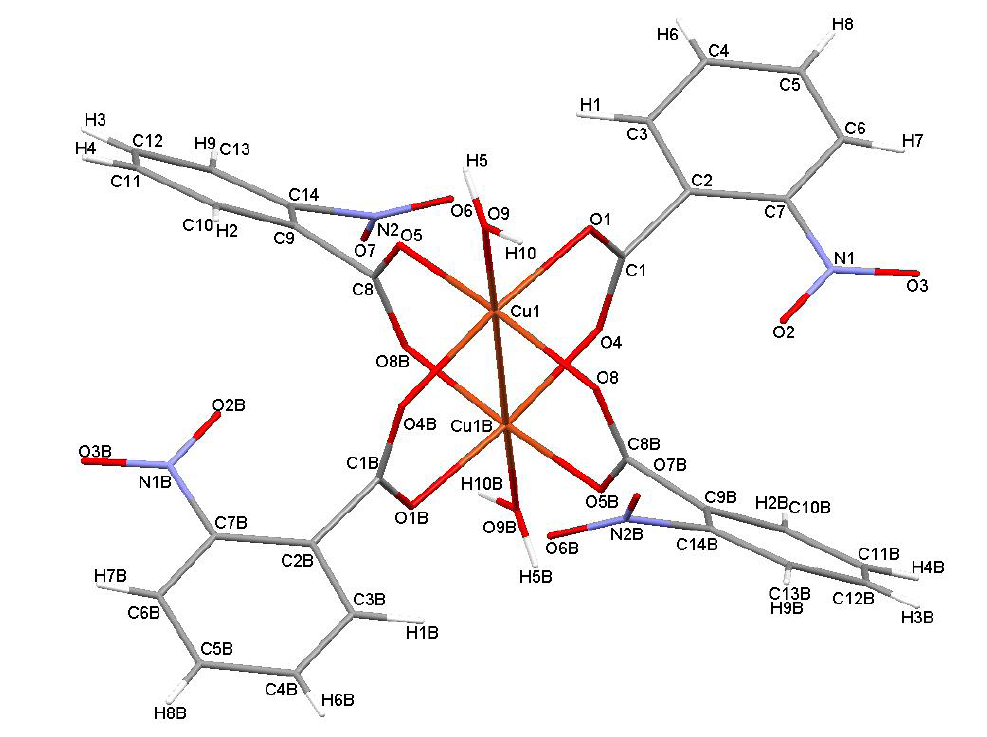
Figure 4. Crystal structure of tetrakis(μ